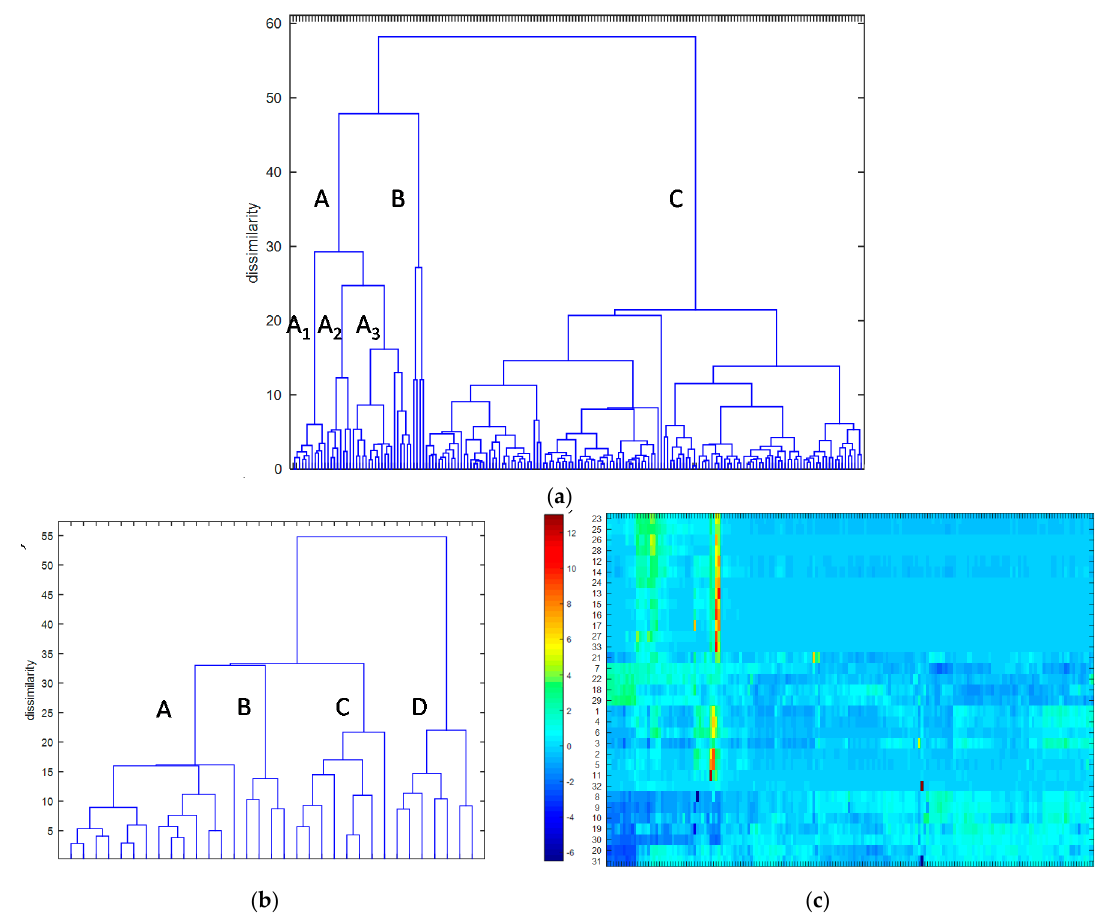
Figure 2. Dendrograms of ( a ) objects (days when samples were collected) in the space of 33 parameters (listed in Table 1) and ( b ) variables in the space of 180 objects with ( c ) a color map of the studied data sorted according to the Ward linkage method.